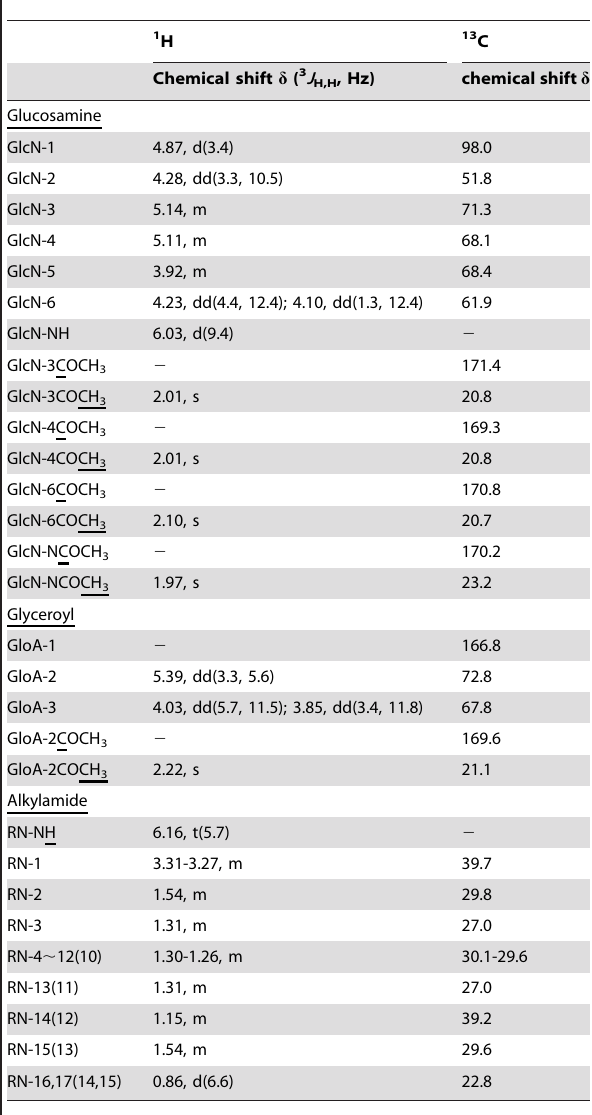
Table 4. NMR data of alkali-hydrolyzed and per-acetylated products of the acidic glycolipid (AGL-B) from T. thermophilus